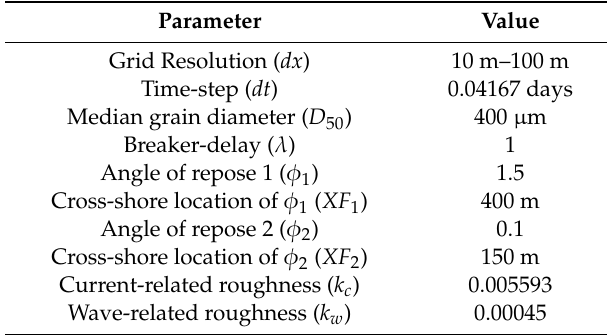
Table 2. Calibration parameters of the brute force model of Anmok